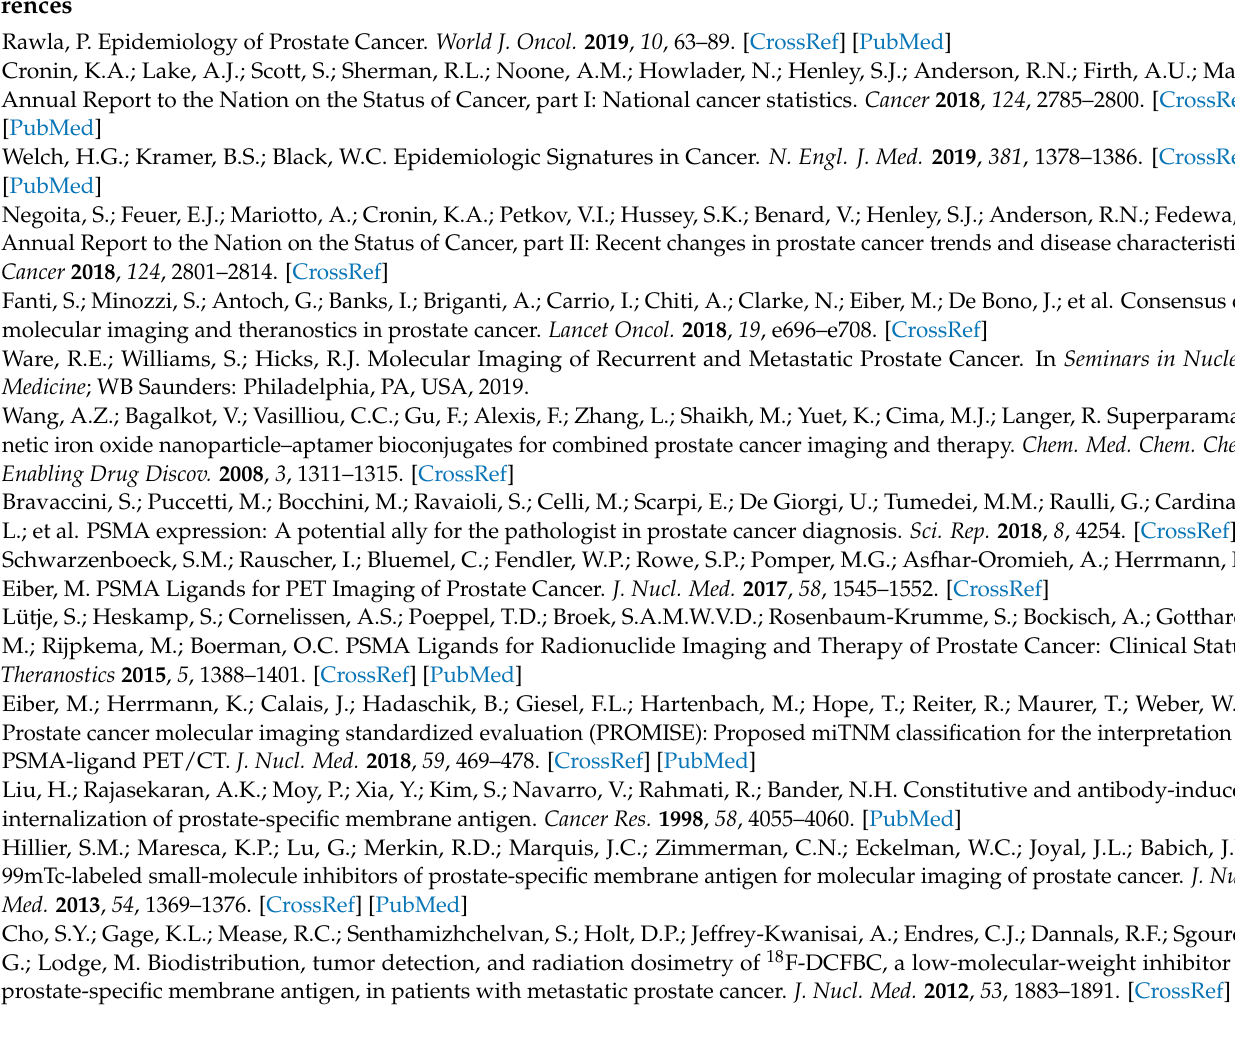
S1: The synthesis of PSMA-1. Supplementary Figure S2: 1 H and 13 C NMR spectra of PSMA-1 and intermediates; Supplementary Figure S3: HRMS spectra of PSMA-1 and